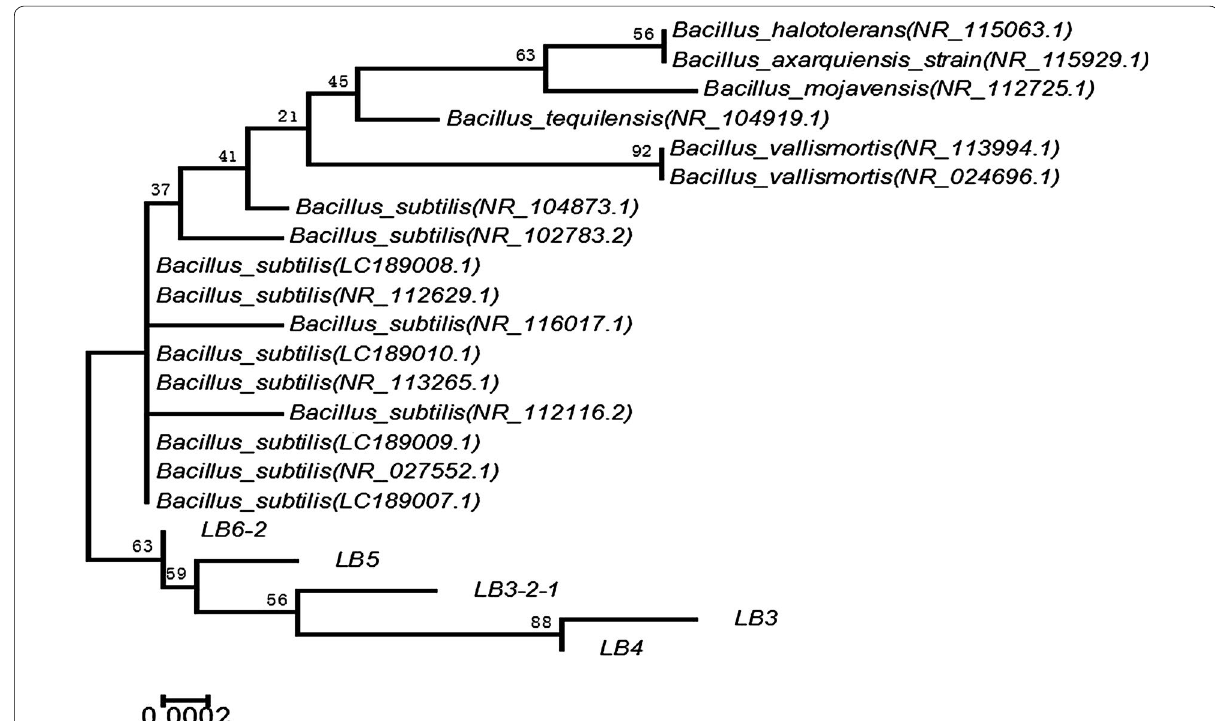
Fig. 2 The neighbour-joining phylogenetic tree of five strains of endophytic bacteria. The representative strains that have been identified as B. subtilis from Genebank were selected to construct the neighbour-joining phylogenetic tree by MEGA 6.0 software. The values of confidence levels